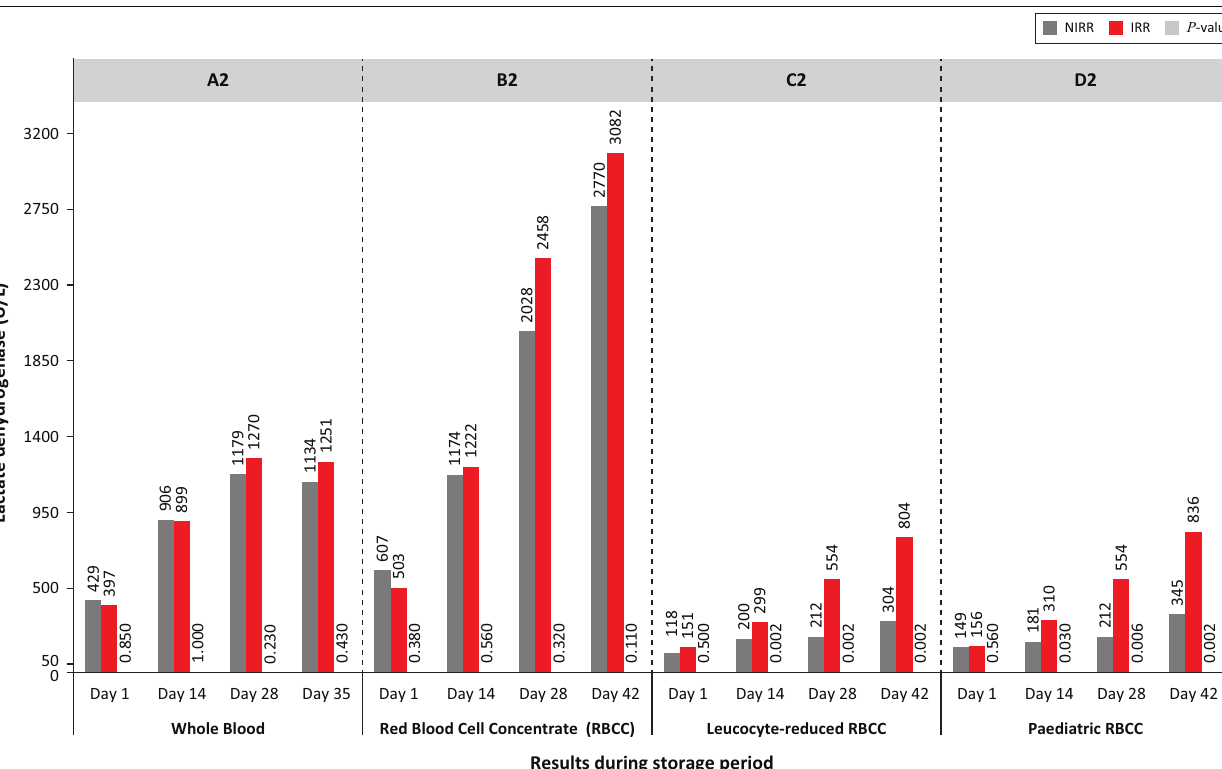
IRR, irradiated; NIRR, non-irradiated; RBCC, red blood cell concentrate FIGURE 2: Lactate dehydrogenase (LDH)